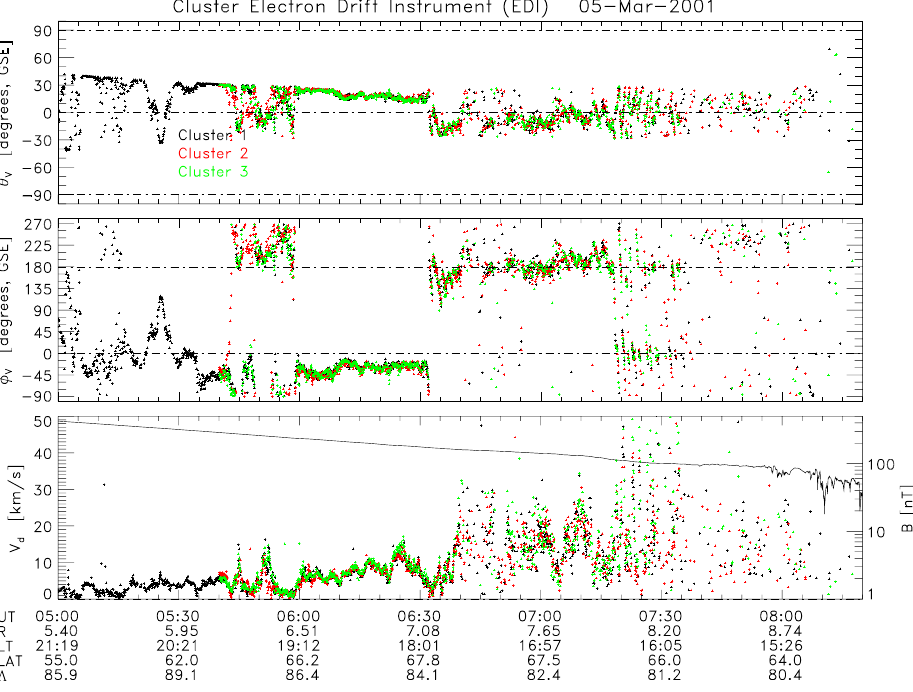
Fig. 12. Outbound pass on 5 March 2001 in the same format as Fig. 7. Note that until 05:40 only SC1 data are available.